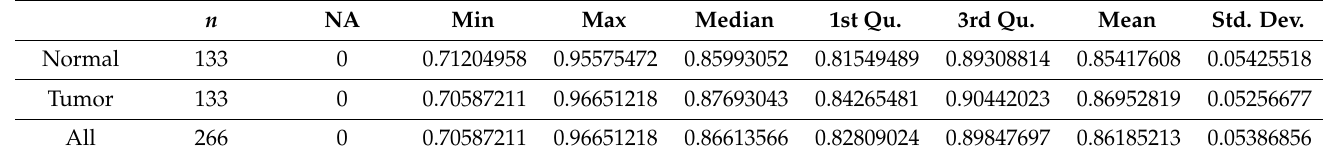
Table 6. Lung β -values and statistics.